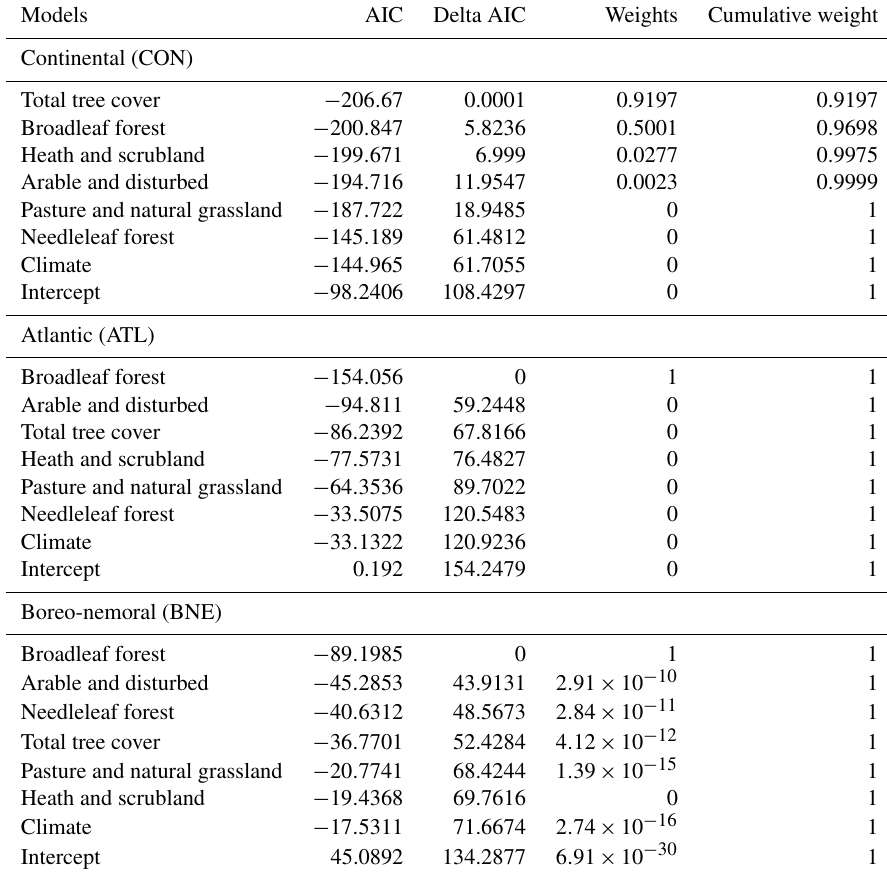
Table 2. Model selection results for generalized additive models of the effects of land cover and climate on biomass burning for the period 8–0ka. Model selection metrics were obtained using the summary functions in the mgcv and qpcR packages in R. Lower values of Akaike information criterion (AIC) and higher values of AIC weights identify the models that were best able to predict the observed changes in biomass burning. Delta AIC values measure the relative performance of each model compared to the best model for that region; a delta AIC of > 2 between two models is typically considered to indicate a significant difference in explanatory